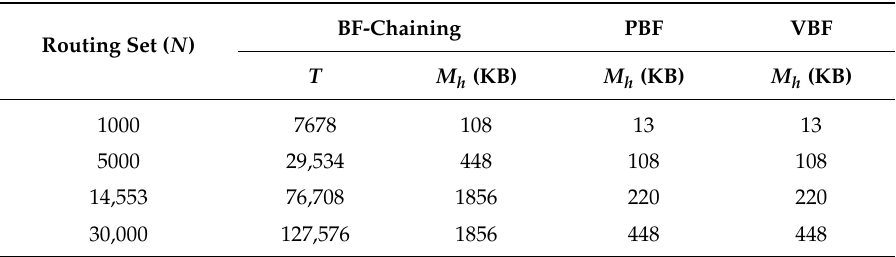
Table 5. Comparison of off-chip memory